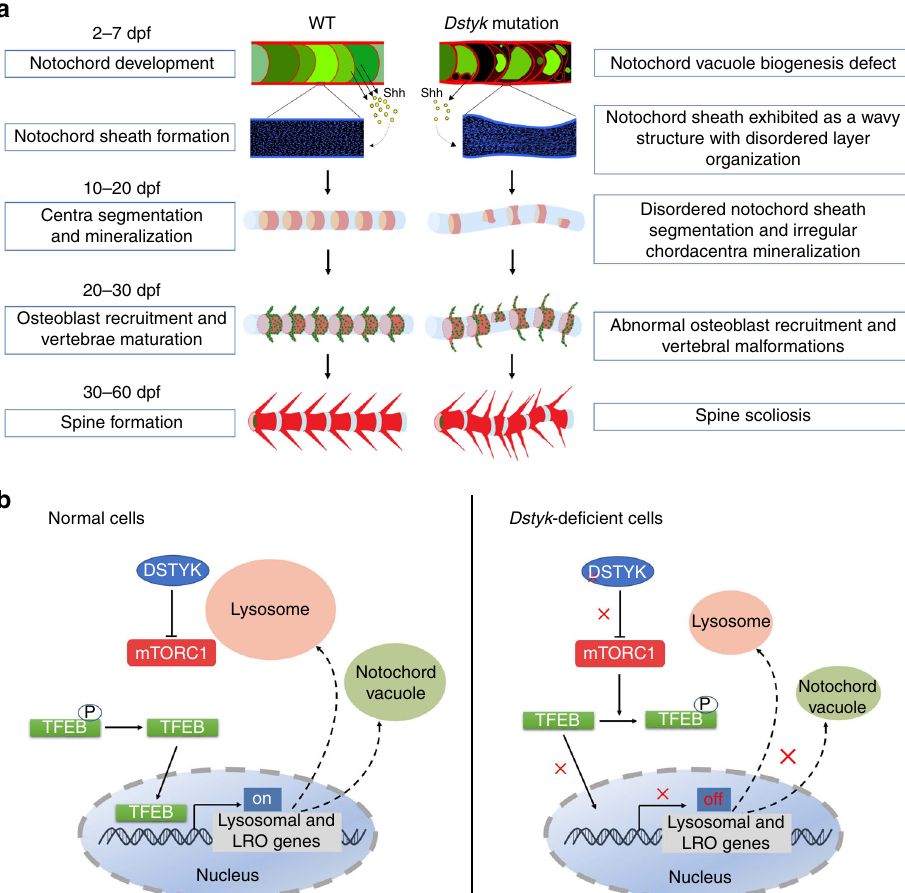
Fig. 10 Schematic diagram for vertebral column development and proposed model for the regulation of mTORC1/TFEB pathway by DSTYK. a The development process of notochord and vertebral column in WT and dstyk mutant (See also in “ Discussion ” ). b Model depicting the proposed mechanistic regulation of TFEB by DSTYK. In normal cells, DSTYK could inhibit the activity of mTORC1, resulting in nuclear translocation of non-phosphorylated TFEB and promoting lysosomal and LRO genes transcription. In Dstyk -de fi cient cells, mTORC1 is activated and phosphorylates TFEB, resulting in reduced TFEB nuclear translocation and inhibition of lysosomal and LRO genes